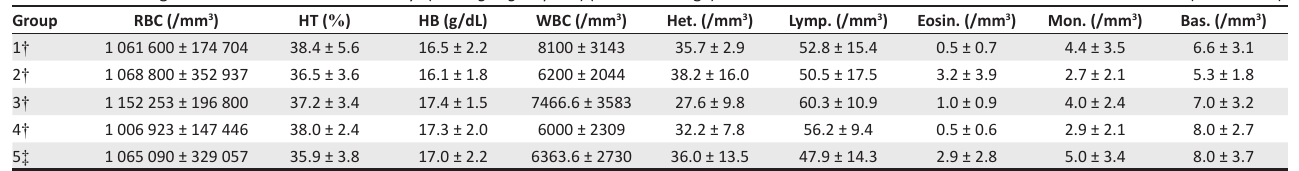
TABLE 2: Haematological values in female bronze turkeys ( Meleagris gallopavo ) (32 weeks of age) vaccinated with various commercial strains of Newcastle disease (mean ± s.d.). Group RBC (/mm 3 ) HT ( % )